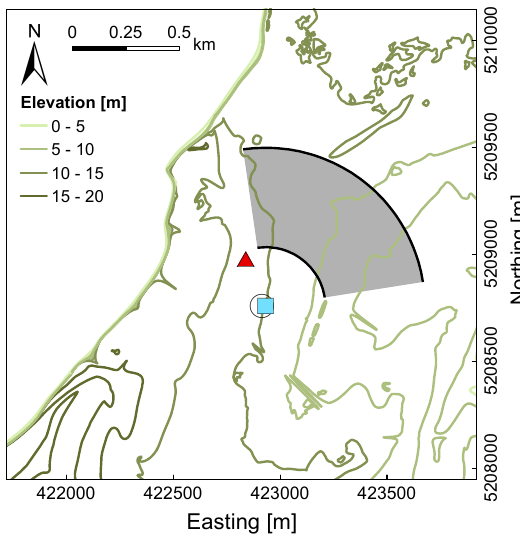
Figure 2. Map of the experiment site (NAD1983, UTM Zone 20 N) showing the locations of the turbine (hollow circle), LiDAR (blue square), the meteorological mast with the sonic anemometer (red triangle), elevation contours and the azimuthal span of sector scans from 3–8 D downstream of the instrument, when the wind direction is aligned with the center of the